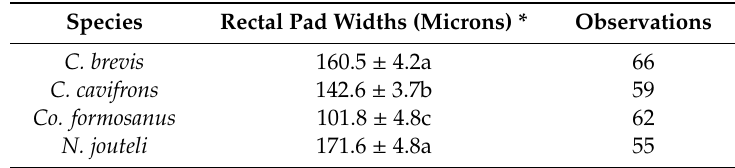
Table 2. Rectal pad widths (mean ± SEM) of four termite species.